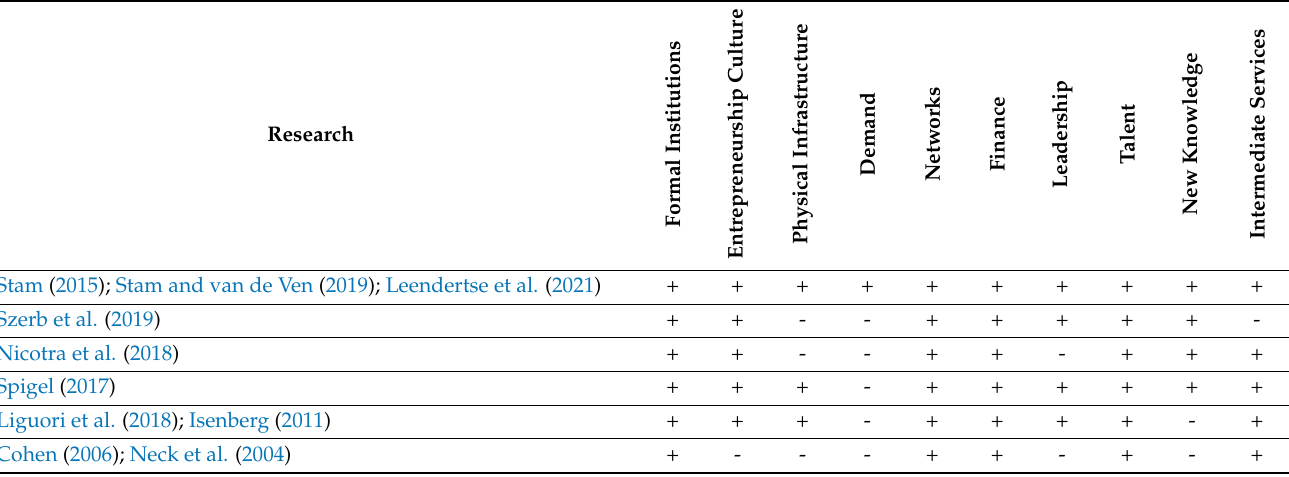
Table 1. Overview of entrepreneurial ecosystem attributes.